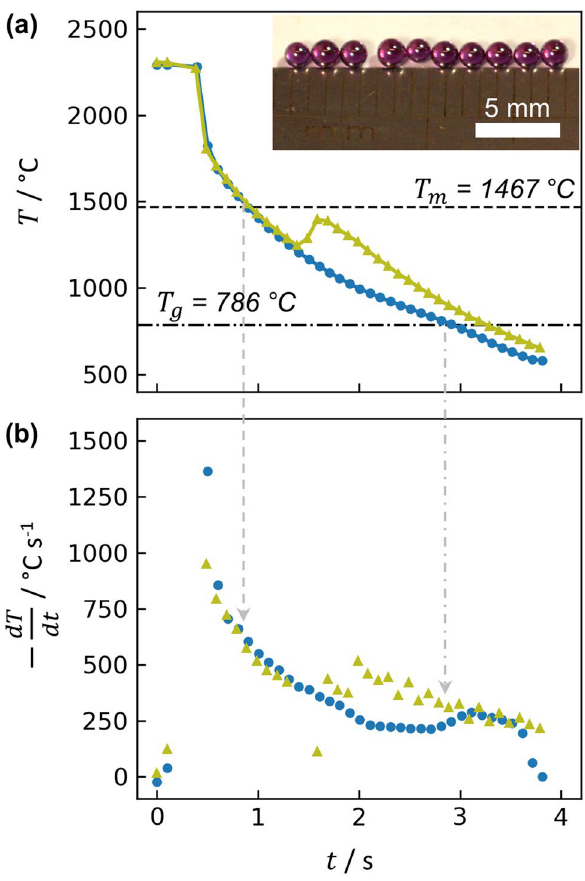
Figure 1. ( a ) Temperature and ( b ) cooling rates of two exemplary beads of 83TiO 2 -17Nd 2 O 3 prepared via aerodynamic levitation and laser melting. For sufficiently fast cooling, beads formed glass (blue curve); otherwise, recalescence occurred due to crystallization and caused a momentary increase in temperature (green curve). Inset: photo of glass